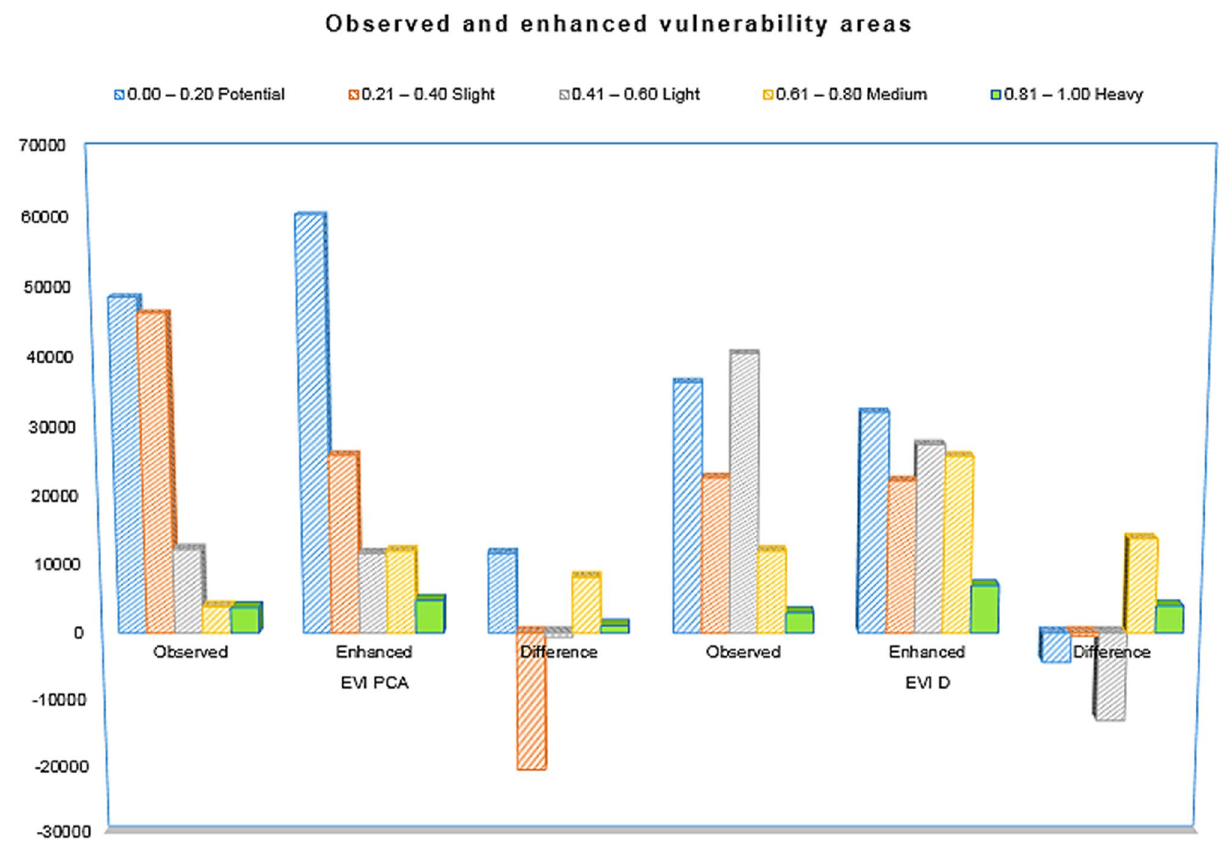
Figure 7. Synthesis of different classified